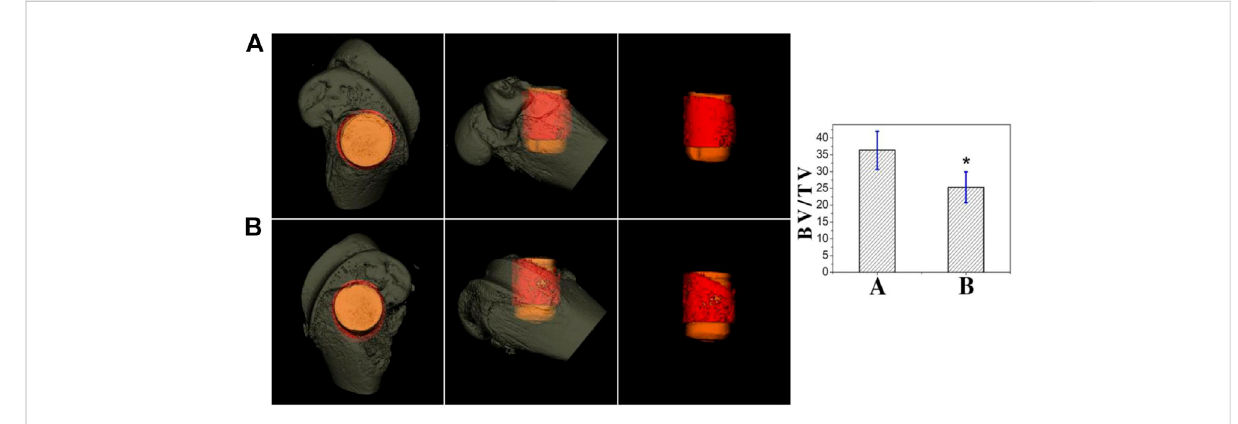
FIGURE 11 Micro-CTresultsofdifferentsamplesat4 weeksafterimplantation( (A) :TCP-SAgroup; (B) :Tigroup).Datawereexpressedasmean±SD( n =3). * p <